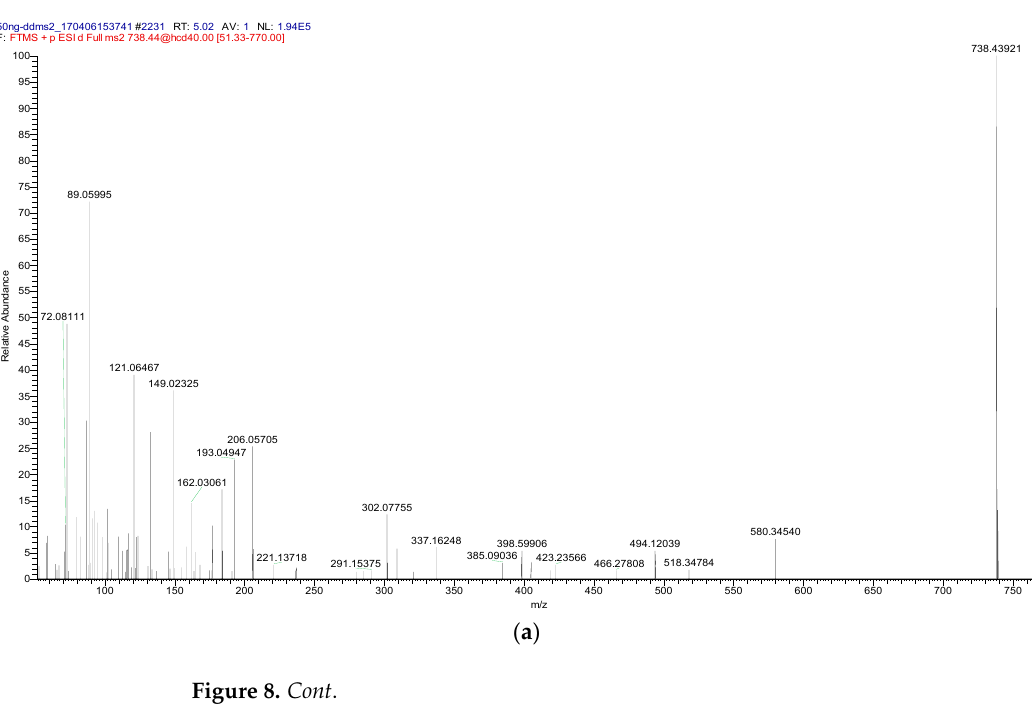
Figure 7. Effects of three efflux inhibitors on peptide segment transport. ( A ) RYPLGYL. ( B ) KHPIKH. ( C ) KHPIK. ( D ) FFSDK. ( E ) YGG. Data are presented as the mean ± SD ( n = 6). ns, p > 0.05; *, p < 0.05; **, p < 0.01; ***, p < 0.001 versus control group.